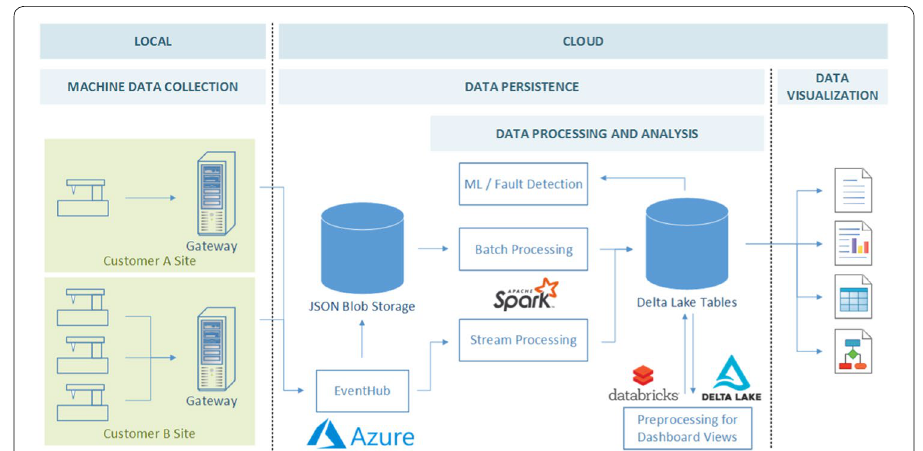
Fig. 2 Schematic view of the system architecture and the process